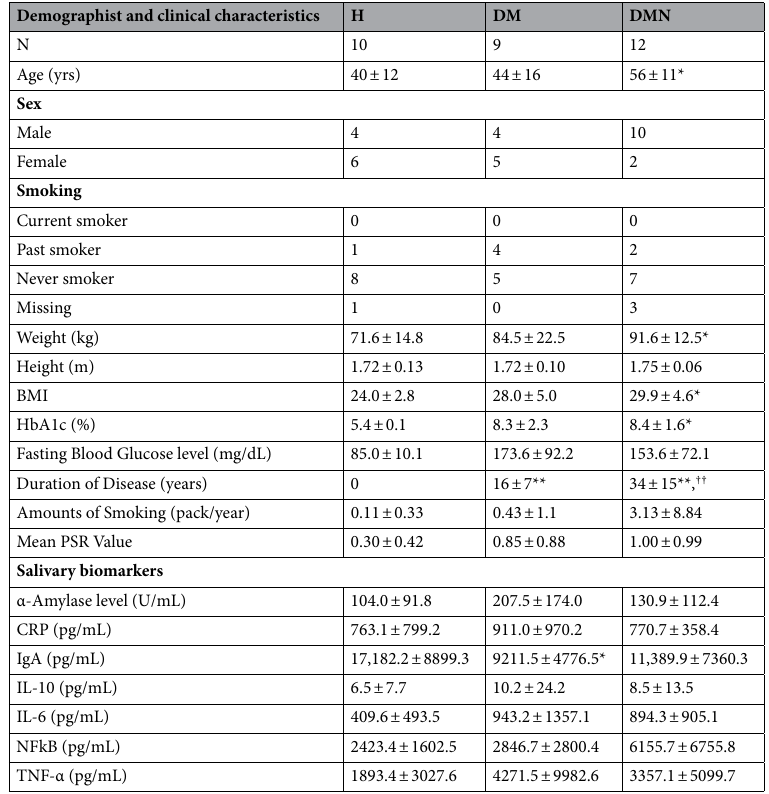
Table 1. Demographic and periodontal parameters of the three experimental groups. Sociodemographic parameters and saliva biomarker levels are shown. Data are presented as mean ± standard deviation. Tukey test (for continuous data) and/or Chi-square test (for categorical data) were used to assess differences between groups. a) Significantly different from H, *p < 0.05, **p < 0.01. b) Significantly different from DM, †† p < 0.01. H: Healthy subjects, DM: individuals with diabetes without neuropathy, DMN: individuals with cardiovascular autonomic diabetic neuropathy, N: sumple numbers, BMI: Body Mass Index, PSR: Periodontal Screening Record, CRP: C-reactive protein, IgA: Immunoglobulin A, IL: Interleukin, NFκB: nuclear factor kappa-light- chain-enhancer of activated B cells, TNF: Tumor Necrosis Factor.